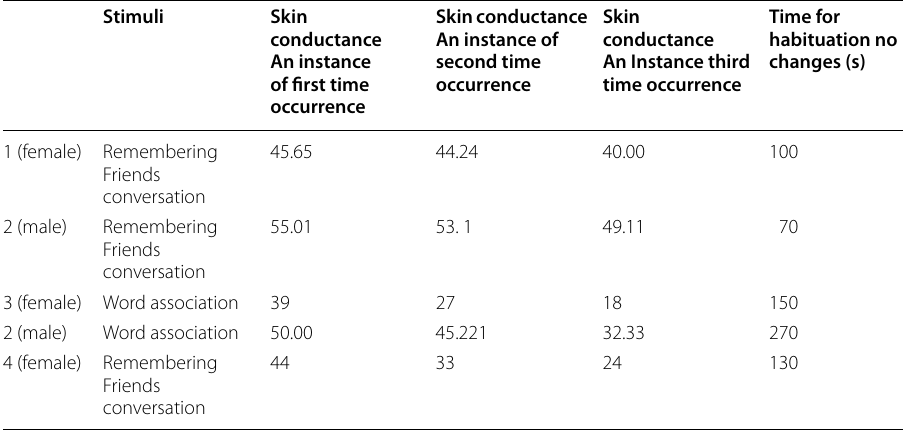
Table 6 Statistics of the GSR observations of the subjects for skin conductance and resistance Stimuli Skin Skin conductance Skin conductance An instance of An instance second time of first time occurrence occurrence